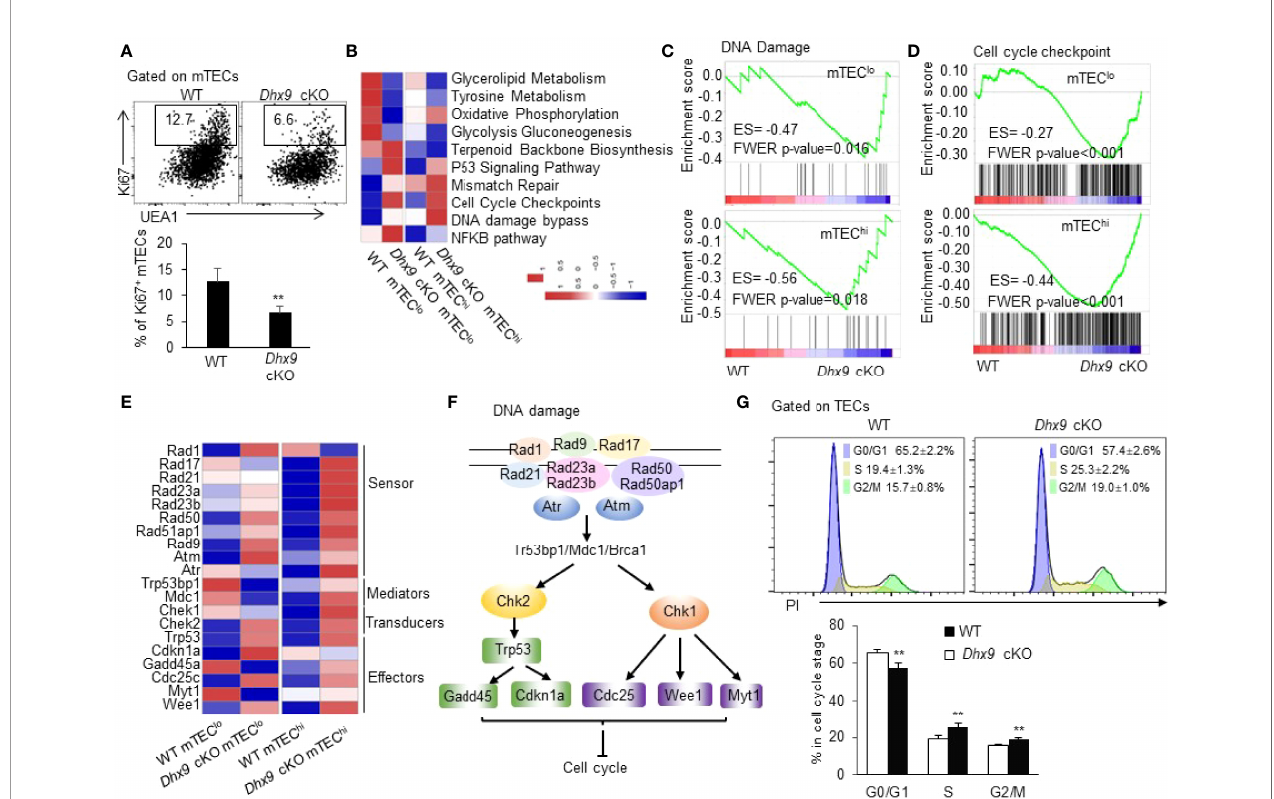
FIGURE 6 | Dhx9 ablation in TECs impaired cell proliferation via cell cycle arrest. (A) Representative fl ow cytometric plots and frequency of cells intracellularly stained with Ki67 in mTECs from 4-week-old WT and Dhx9 cKO mice ( n = 5 for each group). ** P < 0.01 (student ’ s t -test). (B) A row-normalized heatmap showing the changed cellular metabolism and proliferation-related gene pathways in mTEC lo and mTEC hi from WT and Dhx9 cKO mice analyzed by GSVA. The cutoff criterion was P < 0.05. (C) GSEA exhibited an enrichment of the DNA damage gene set in Dhx9 -de fi cient mTEC lo and mTEC hi , as de fi ned by the criterion P < 0.05. (D) An enrichment of the cell cycle checkpoint gene set in Dhx9-de fi cient mTEC lo and mTEC hi analyzed by GSEA ( P < 0.05). (E) Heatmap of the signi fi cant changed genes ( P < 0.05) associated with the DNA damage in mTEC lo and mTEC hi from WT and Dhx9 cKO mice. (F) The molecular network of gens listed in (E) describing the connection between the DNA damage process and cell cycle arrest. (G) The cell cycle distribution for WT and Dhx9 KO TECs ( n = 4 for each group) was measured using propidium iodide (PI) straining via fl ow cytometry. The data were shown as mean ± SD. ** P < 0.01 (student ’ s t